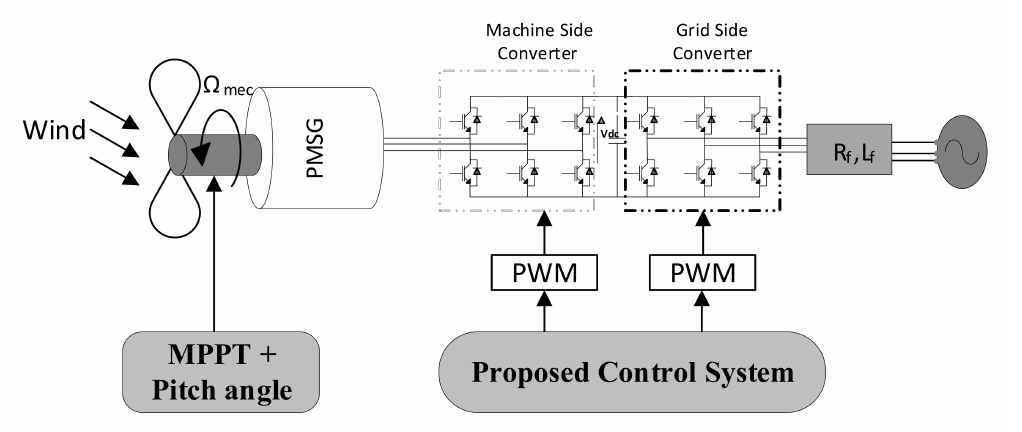
Figure 1. WECS global